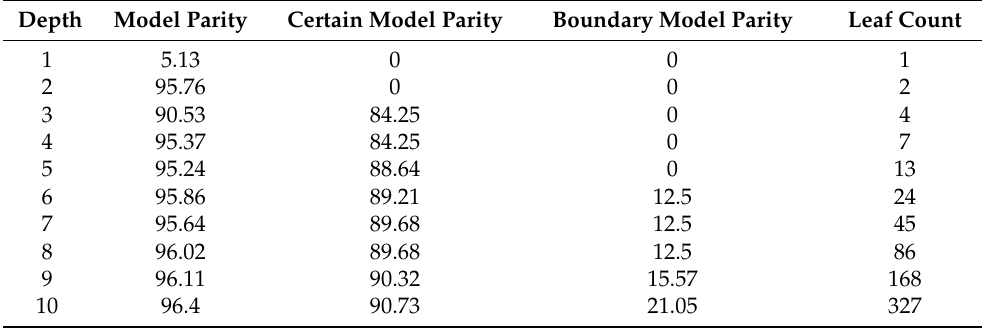
Table 6. Evaluation of the interpretable models for the US Adult Census dataset generated by MTRE-PAN at depths ranging from 1 to 10.